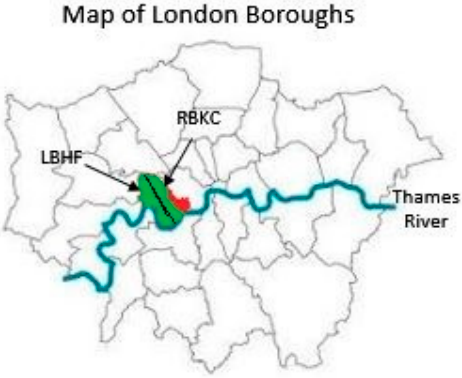
Figure 2. Counters Creek Catchment (in green) within the London Borough of Hammersmith (LBHF) and The Royal Borough of Kensington and Chelsea (RBKC), London, UK.